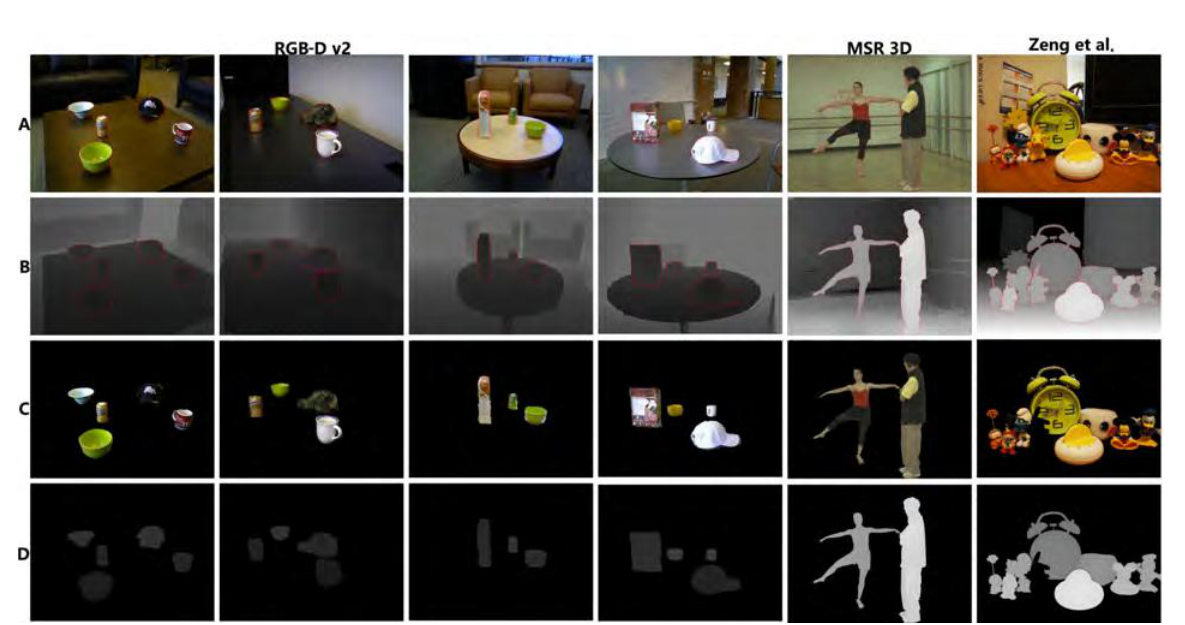
Fig. 2 Extraction results for scenes from different datasets. (A, B) Extracted silhouettes in color and depth images. (C, D) Extracted foreground objects in color and depth